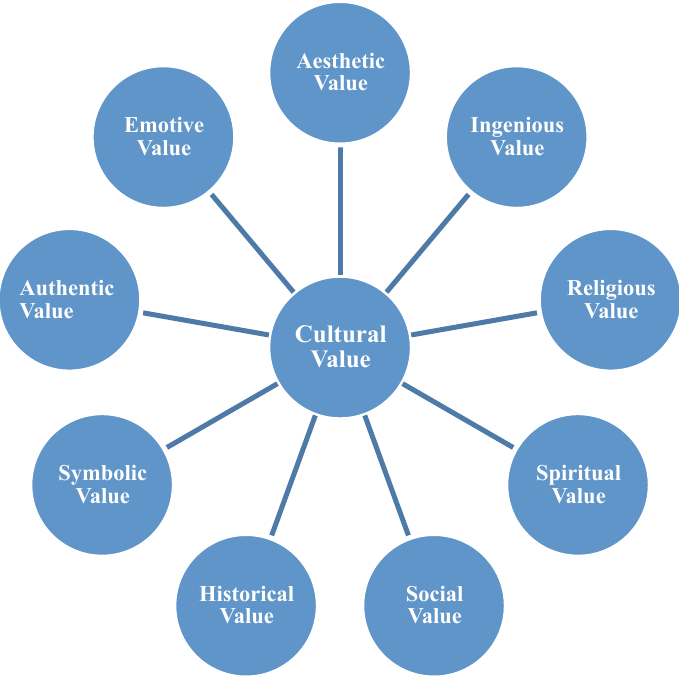
Fig. 1 Typology of the Cultural Values Inherent in Indian Music and